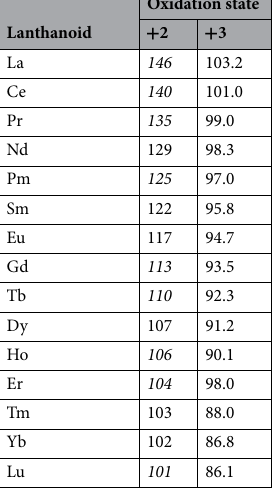
Table 3. Effective ionic radii in picometers (pm) of lanthanoid ions, of both oxidation states, used in the method for the interpolation of coordinate bond lengths. Values in italic were obtained from the quadratic function in Eq.